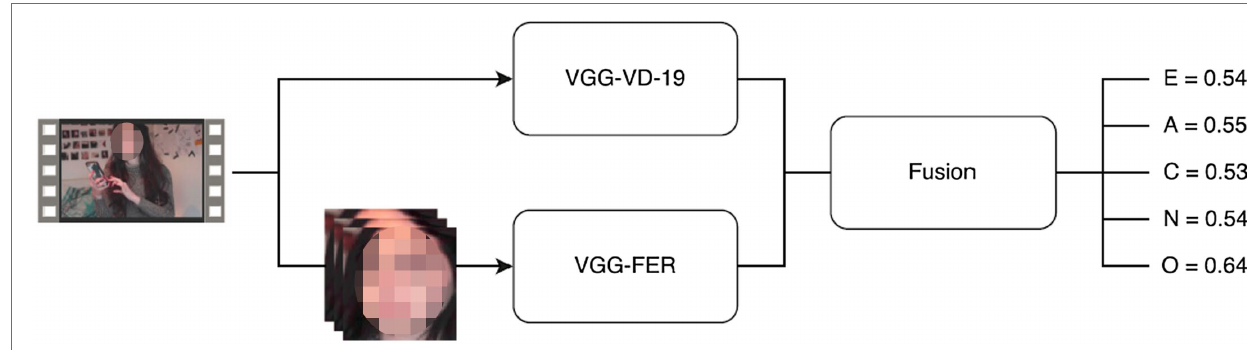
FIGURE 3 | The flowchart of personality trait prediction by using deep facial and scene feature representations (Gürpınar et al., 2016).